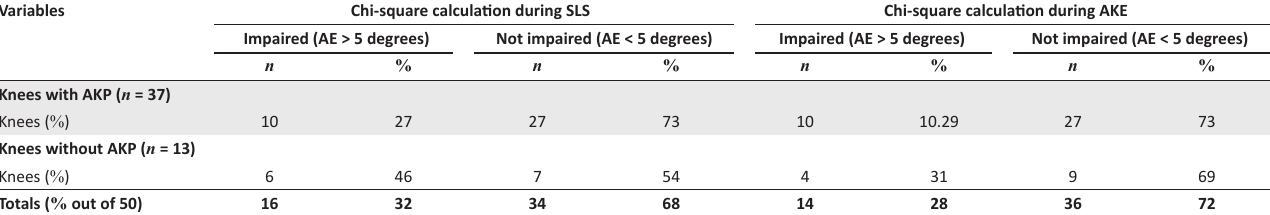
TABLE 3: Joint position sense results between the knees with anterior knee pain and without anterior knee pain (in participants with anterior knee pain). Variables SLS AKE Target angle (TA) Relative error (RE) Relative error (RE) Knees with AKP ( n = 37) Median Knees without AKP ( n = 13) Median IQR SLS, single leg squat; AKP, anterior knee pain; IQR, interquartile range; AKE, active knee extension. TABLE 4: Knees with anterior knee pain compared with knees without anterior knee pain during single leg squat and active knee extension. Variables Chi-square calculation during SLS Chi-square calculation during